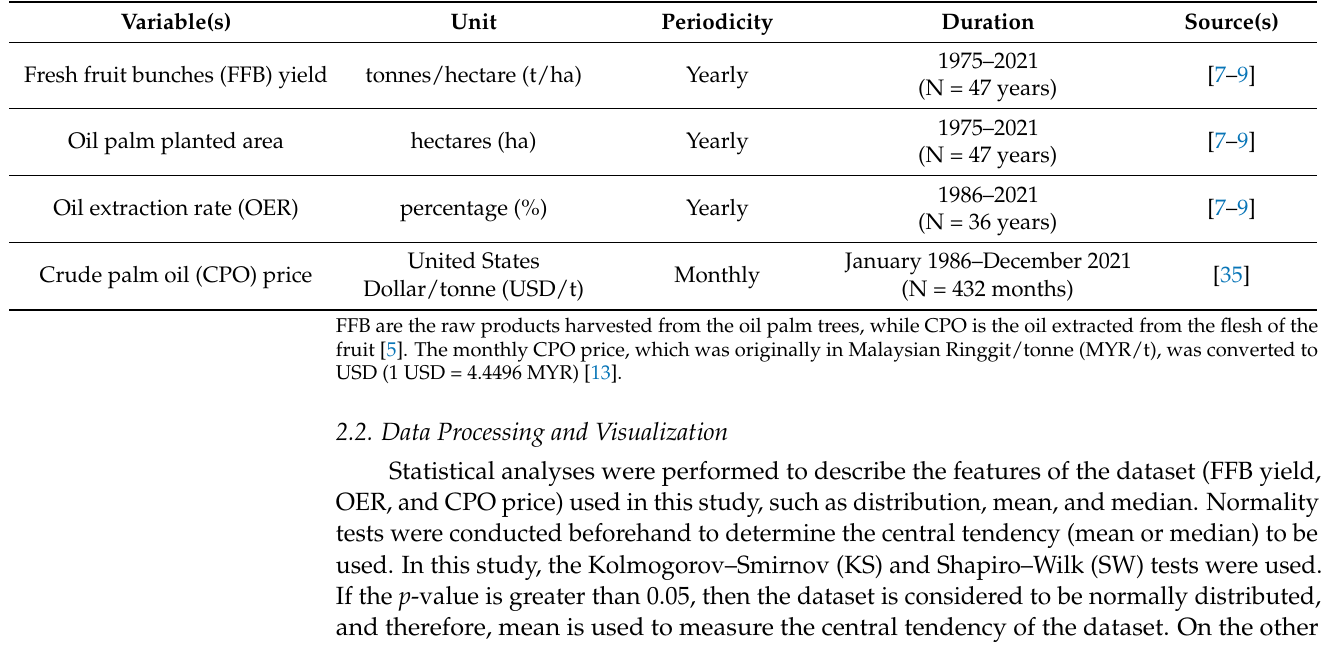
Table 1. Summary of the Malaysian oil palm statistical data collected and used in this